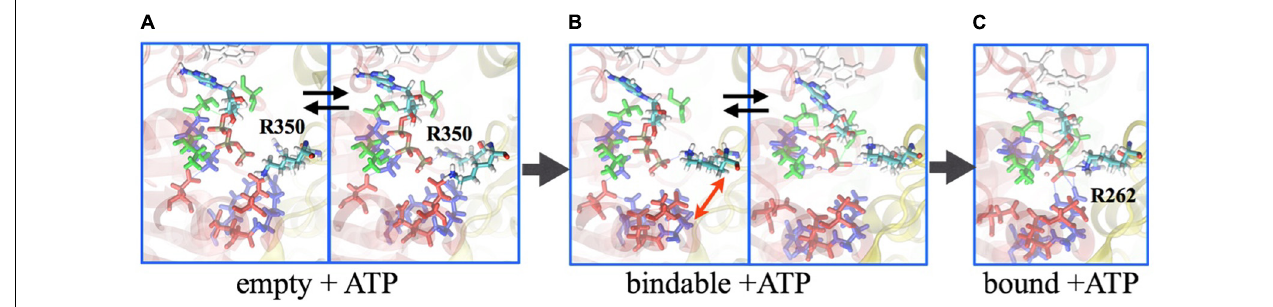
FIGURE 5 | Binding mechanism of ATP. Molecular dynamics simulation reveal that the ATP is excluded from binding to the ‘empty’ site, as the arginine-finger 350 residue sterically prevents the nucleotide entry (A) . In the ‘bindable’ site, isomerization of R350 allows entry of ATP (B) , ensuing interaction with R262 to ensure binding (C) . Labeled in green are residues Q503 and N504, which together with F425 (labeled in white) interact with the adenosine ring; E261 and E262 are labeled in red; G235, G237, and K238 are indicated in blue. Subunit A is presented in transparent red ribbon, and B in